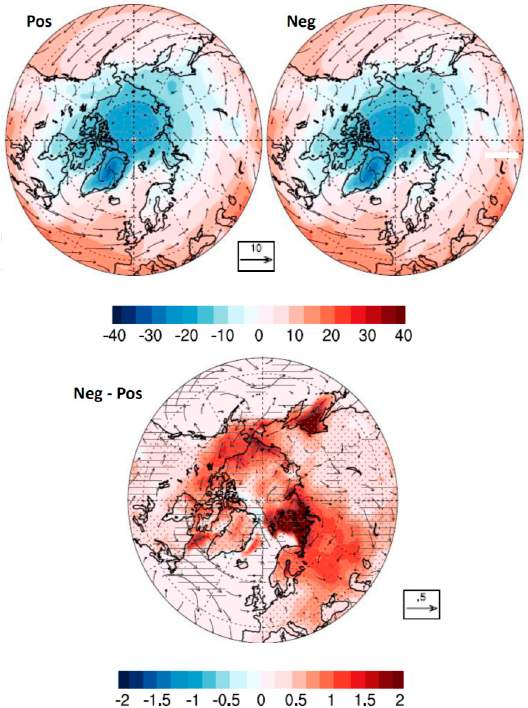
Figure 9. SAT (°C, color) and surface wind (m/s, vectors) composites for Pos and Neg years for and Neg—Pos (Diff) changes during spring. Hatching represents statistically significant SAT anomalies above 95%. Horizontal lines represent statistically significant changes (95%) in surface wind.